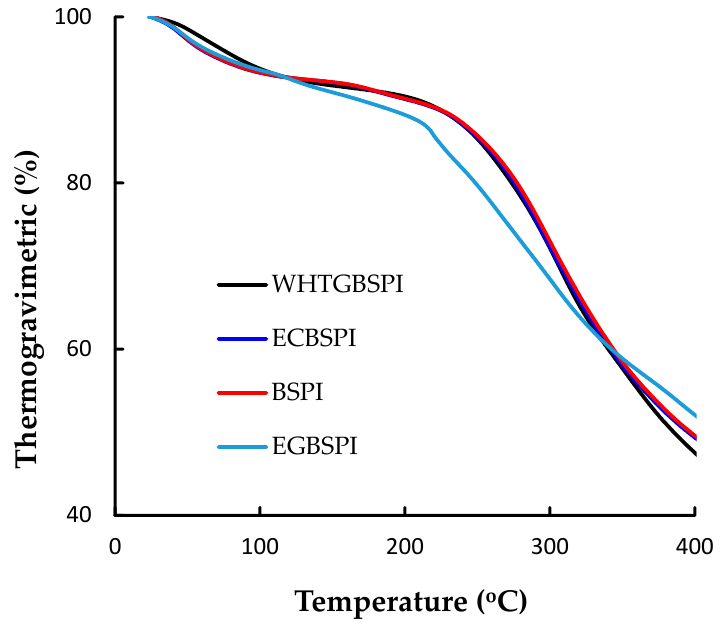
Figure 4. Thermogravimetric curves of BSPI and its modified products.